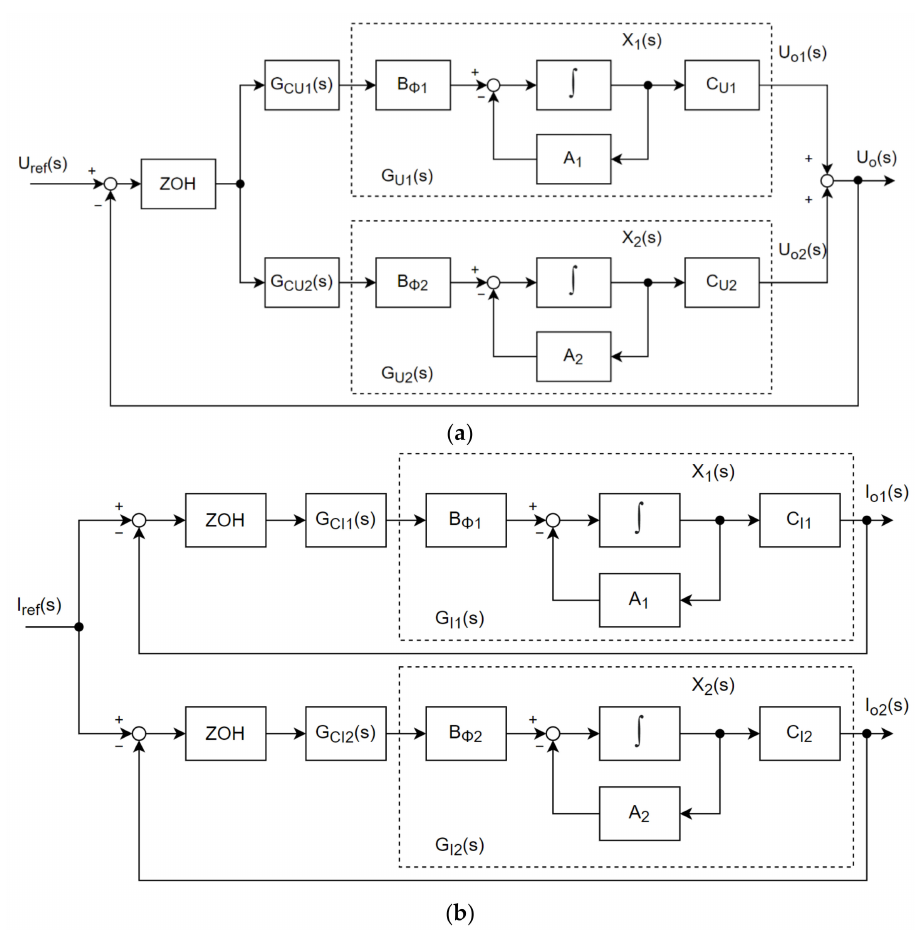
Figure 6. A block diagram of the controlled IPT system using double DD coils. ( a ) output voltage control, ( b ) output current